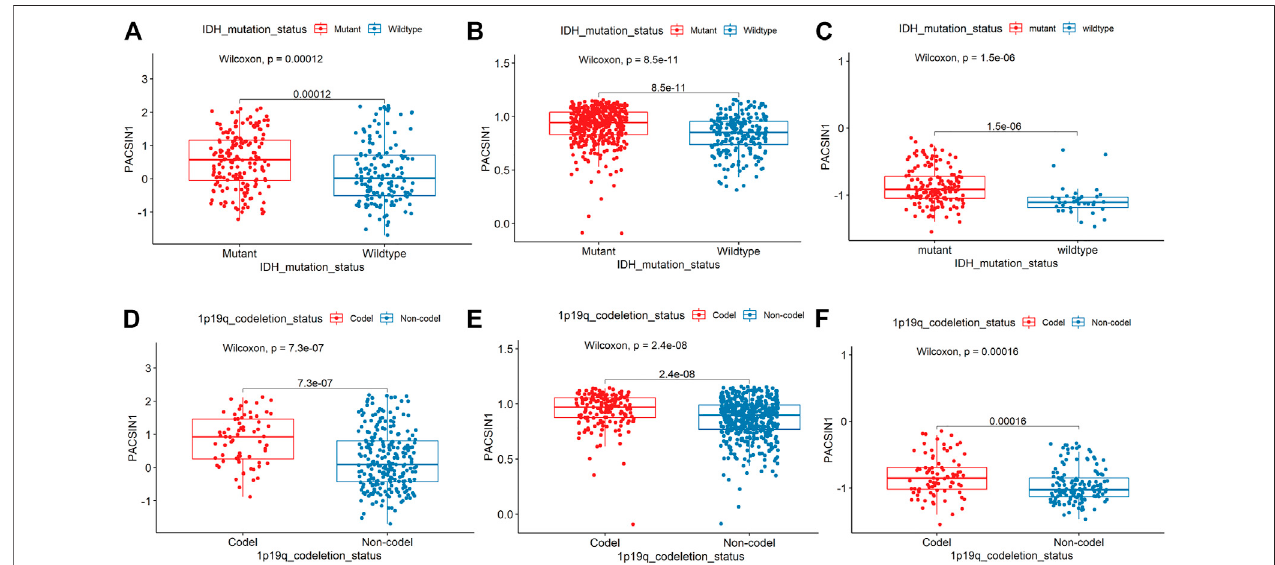
FIGURE3| PACSIN1expression inIDH1mutationstatus and1p/19qcodeletionstatus.PACSIN1upregulatedintheIDH1-mutantgroupinCGGA (A) ,TCGA (B) , GSE 58218 datasets (C) and downregulated in non-codel group in CGGA (D) , TCGA (E) , GSE 58218 datasets (F) .